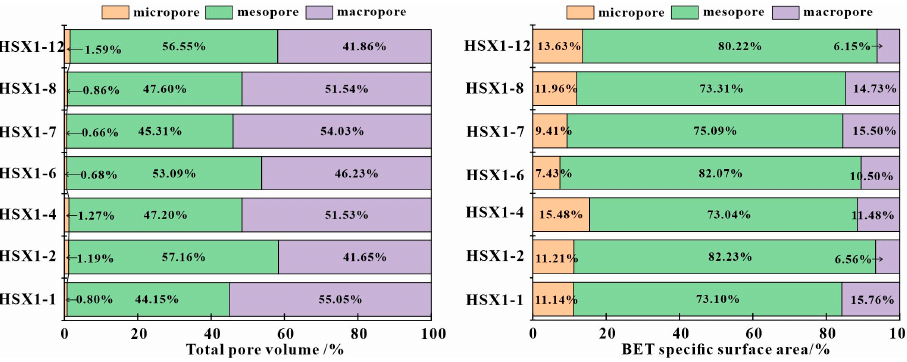
The N 2 adsorption pore size distribution of shale samples is illustrated in Figure 6.